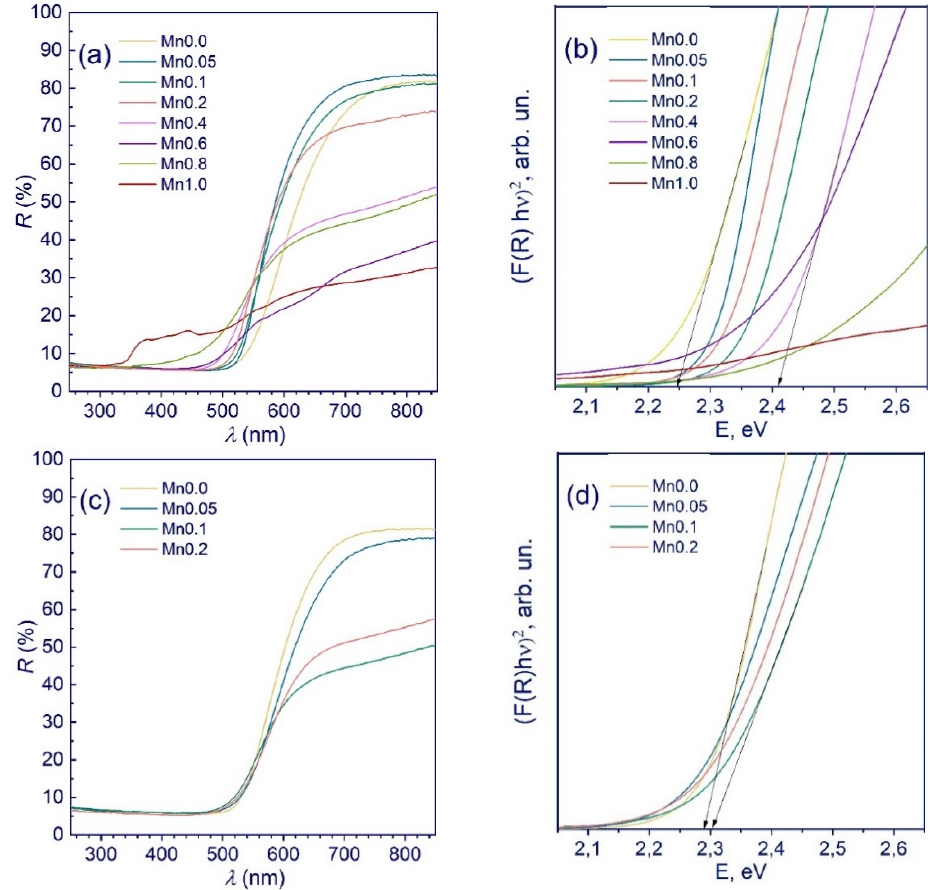
Figure 2. Diffuse reflectance spectra ( a , c ) and Tauc’s plot ( b , d ) of the samples Mnx (x = 0–1.0) ( a , b ) and Mnx(NaOH) (x = 0–0.2) ( c , d